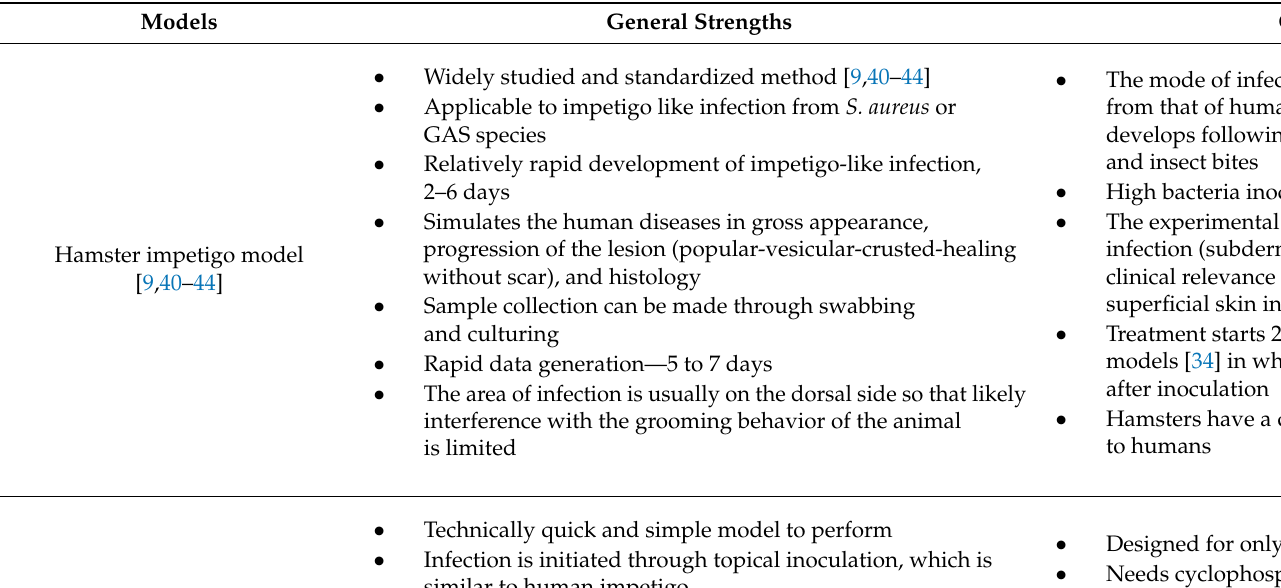
Table 2. A summary of the strengths and limitations of the rodent models investigated for